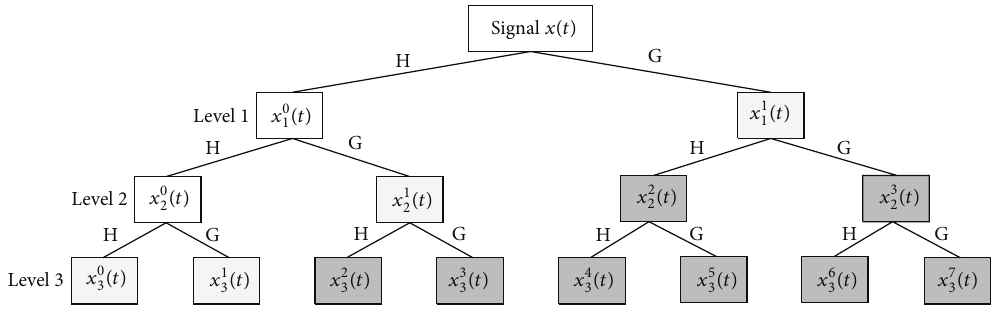
Figure 1: Illustration of a 3-level WPT (H-low pass filter, G-high pass